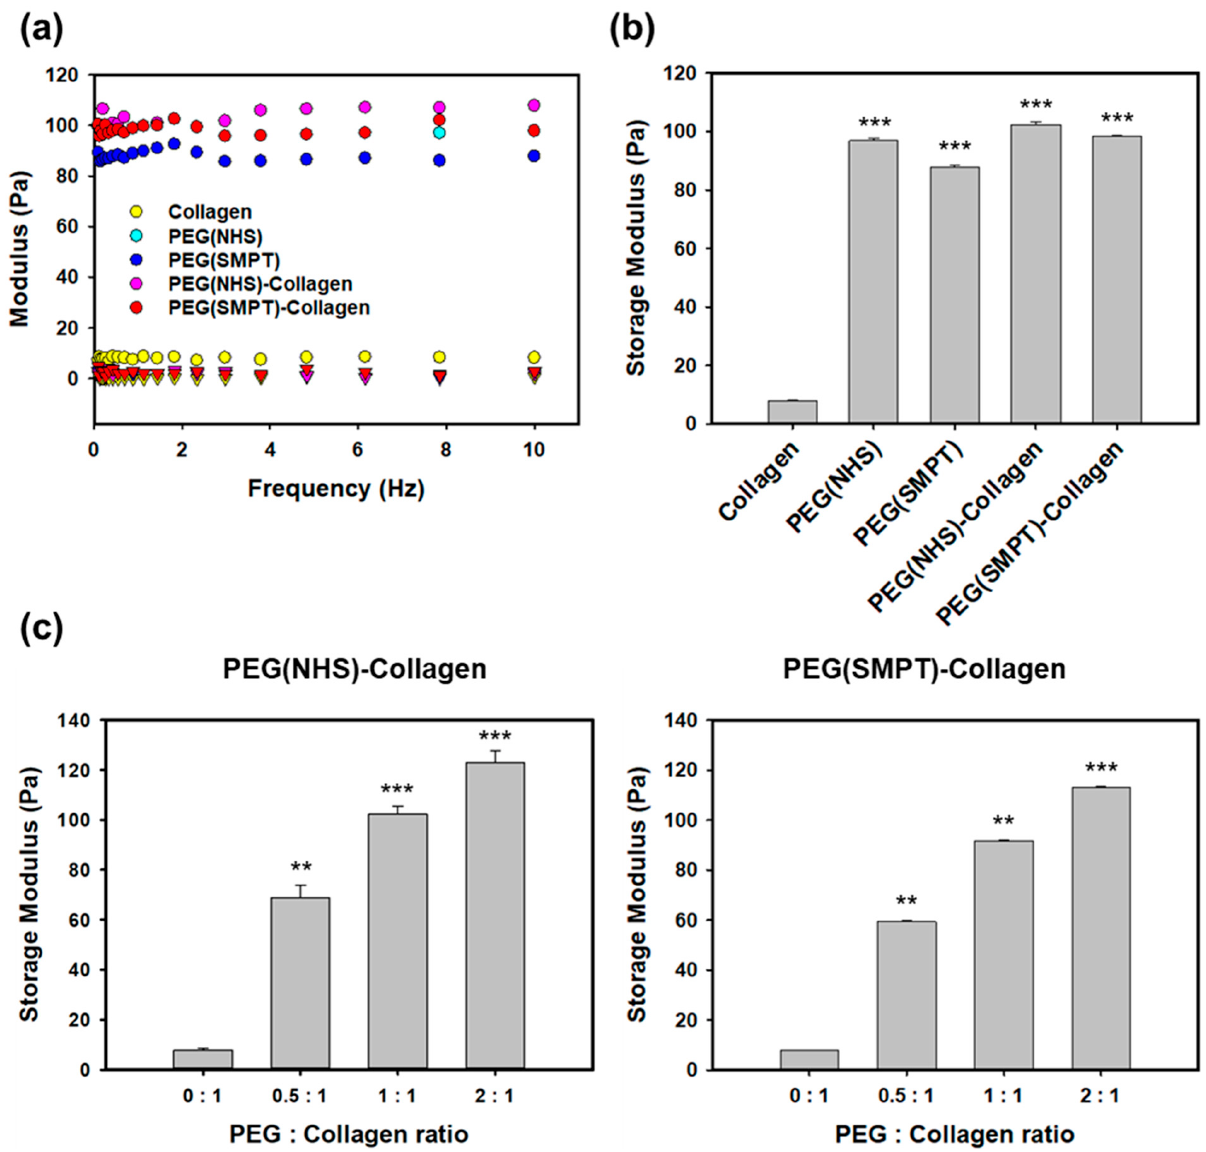
Figure 2. Rheological characterization of hydrogels. ( a ) Storage ( ● ) and loss moduli ( ▼ ) of each hydrogel. ( b ) The averaged storage modulus of each hydrogel. *** p < 0.001 compared with Collagen. ( c ) Variations in storage modulus according to different PEG to collagen ratios for PEG (NHS)- Collagen ( left ) and PEG (SMPT)-Collagen hydrogels ( right ). ** p < 0.01, *** p < 0.001 compared with 0:1 PEG: Collagen